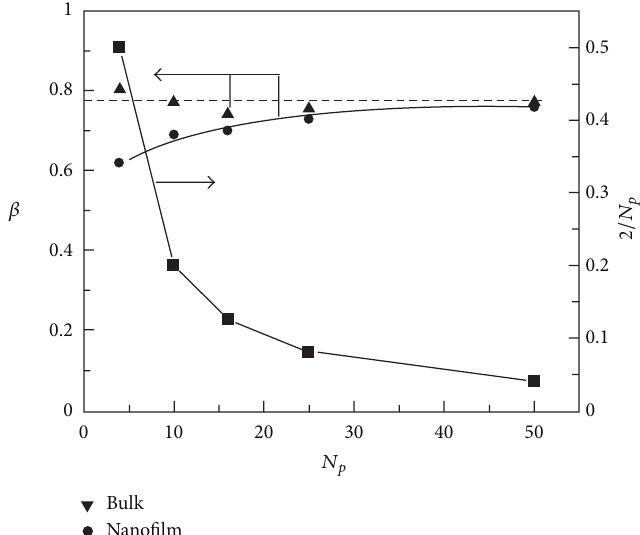
Figure 22: The stretching parameter 𝛽 and end-group ratio 2/𝑁 𝑝 as a function of 𝑁 𝑝 for the PFPE ( 𝜀 𝑝 = 𝜀 𝑝 𝑤 = 2𝜀 ) in the bulk state ( 𝜀 𝑤 = 0 ) and in the nanofilm ( 𝜀 𝑤 = 4𝜀 ) with 𝑇 = 1.0𝜀/𝑘 𝐵 .